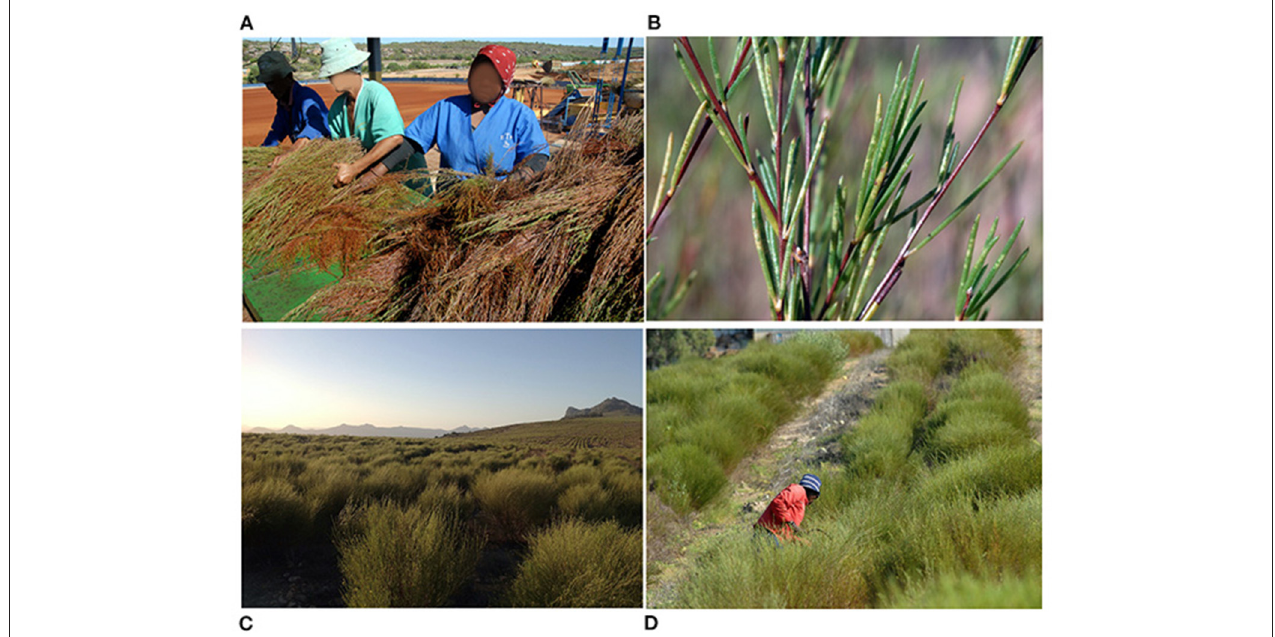
FIGURE 5 | Rooibos (Aspalathus linearis) growing in South Africa. (A) Rooibos bush harvest. Source: R. Bosch. CC BY-SA 2.0. (B) Needle-like leaves of rooibos bush. Source: R. Bosch. CC BY-SA 2.0. (C) Monocultures of rooibos. Source: B. Nel. CC BY-NC-SA 2.0. (D) Woman harvesting rooibos. Source: R. Bosch. CC BY-SA 2.0.